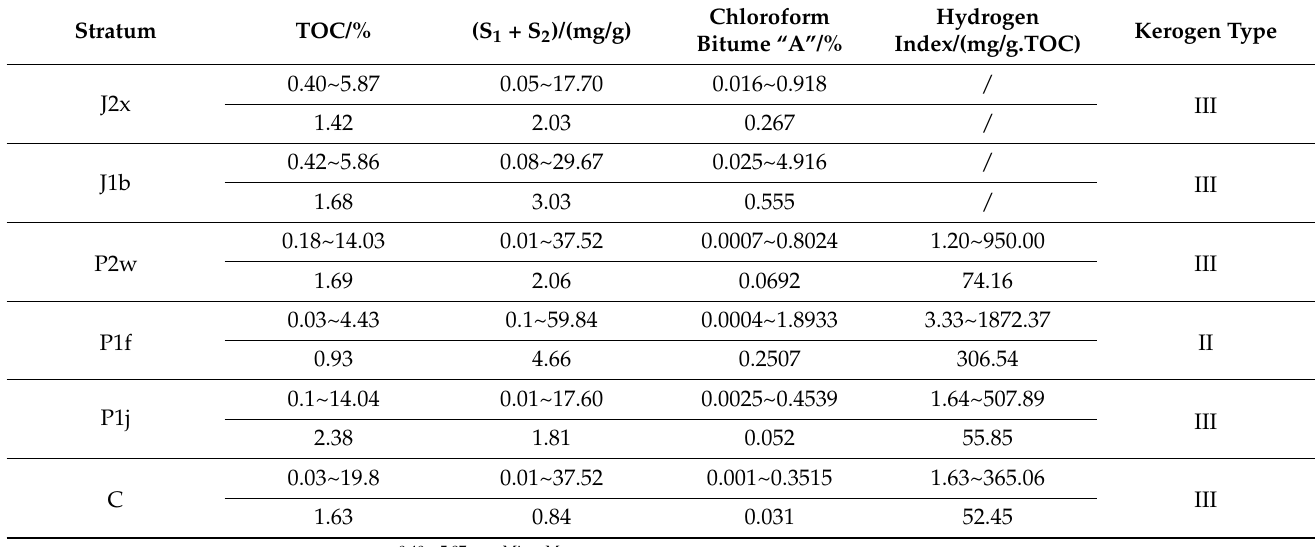
Table 3. Geochemical characteristics of the main source rocks in the Penyijingxi sag, Junggar Basin [47,48].